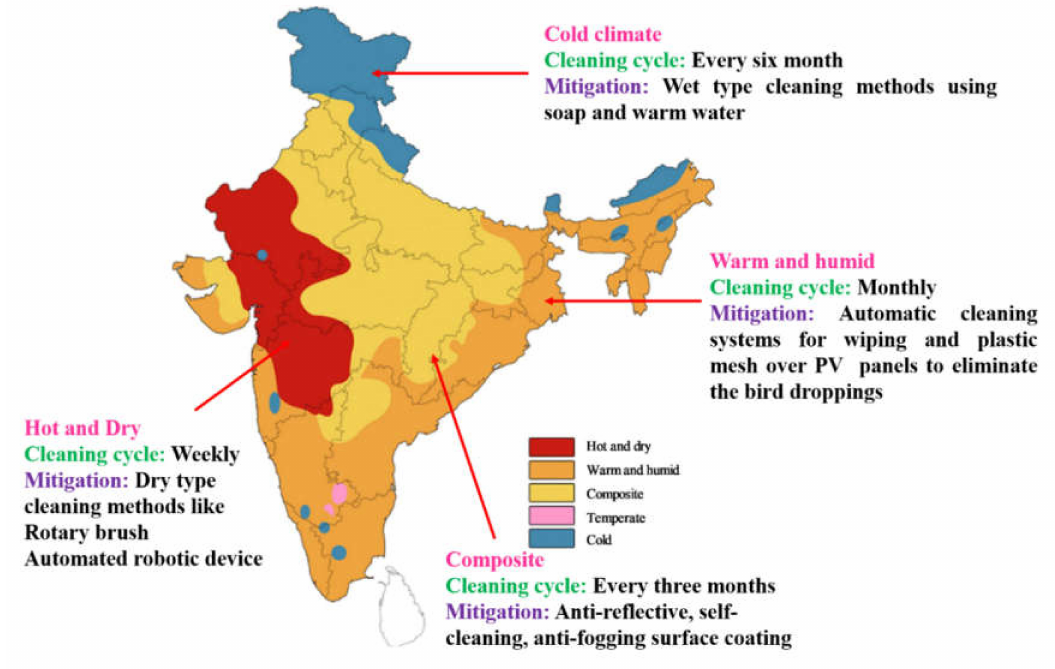
Figure 6. Cleaning system for di ff erent climate zones in